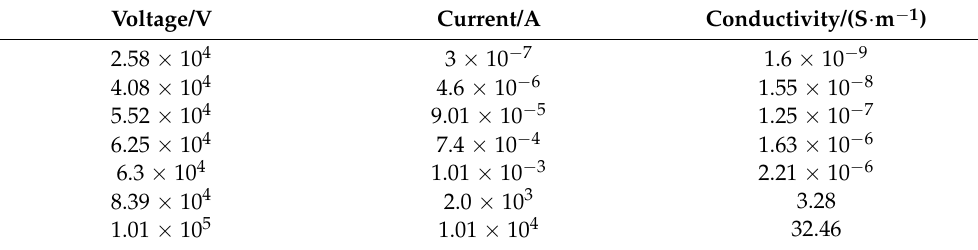
Table 3. Conductivity